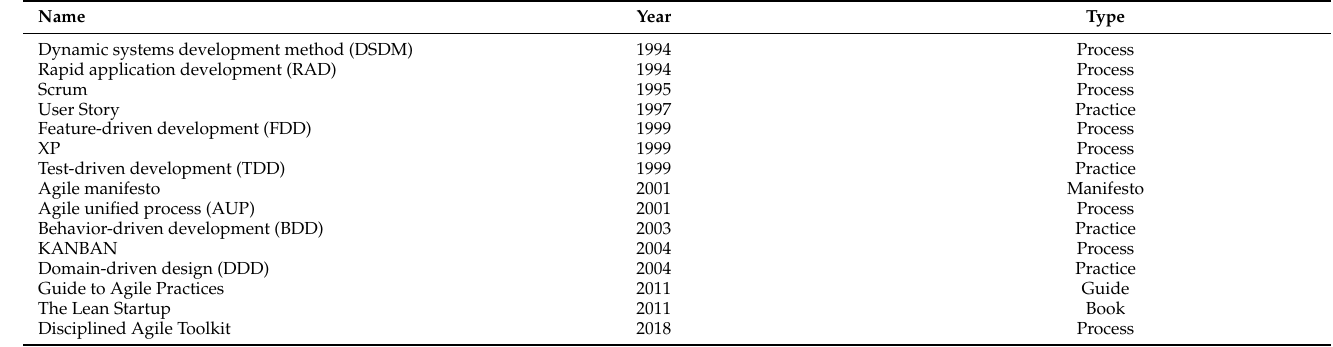
Table 2. Seminal works related to agile methods, from the first years of the 1990s up to